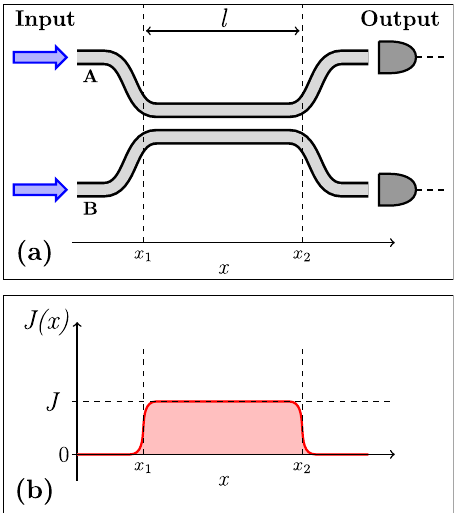
Fig. 3 Elementary QPIC with single hopping region. a Sketch of a polariton circuit made of a pair of co-propagating waveguides, labeled as A and B , which are coupled along a spatial region of length l . b Schematic behavior of the coupling constant, J ( x ), describing the evanescent coupling between the two waveguides of the polariton circuit described in a . In this setup, the coupling is non-zero and equal to a constant value J only in the region x 1 < x < x 2 .